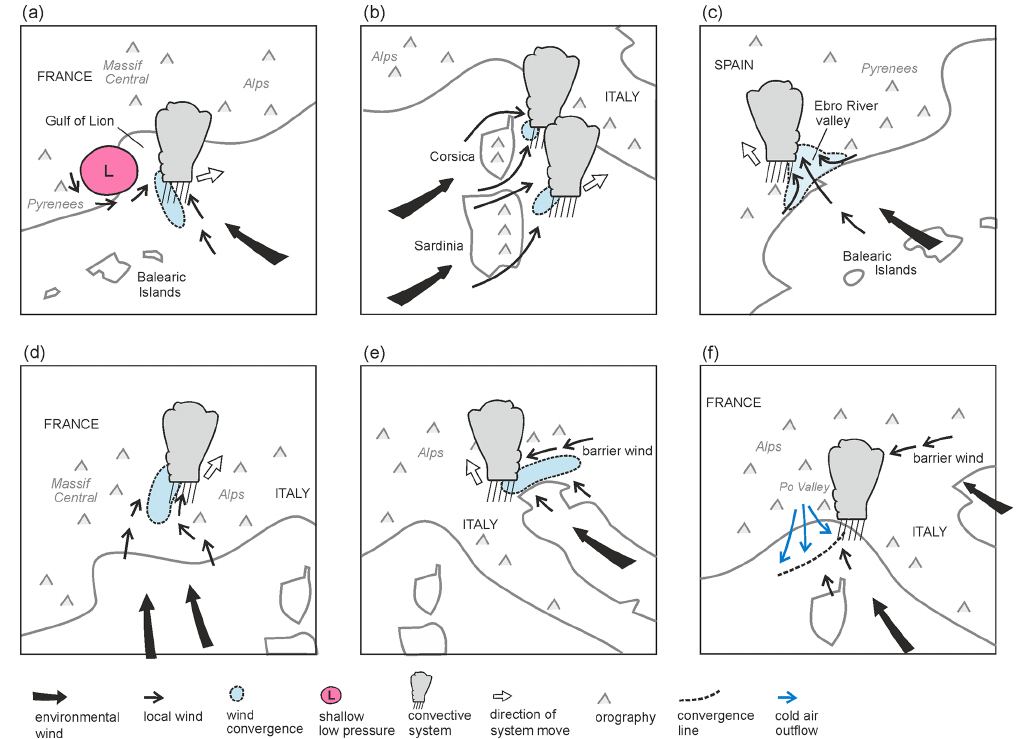
Figure 4. Conceptual illustrations of key convection-triggering mechanisms in the northwestern Mediterranean basin. Coastlines are depicted by grey solid